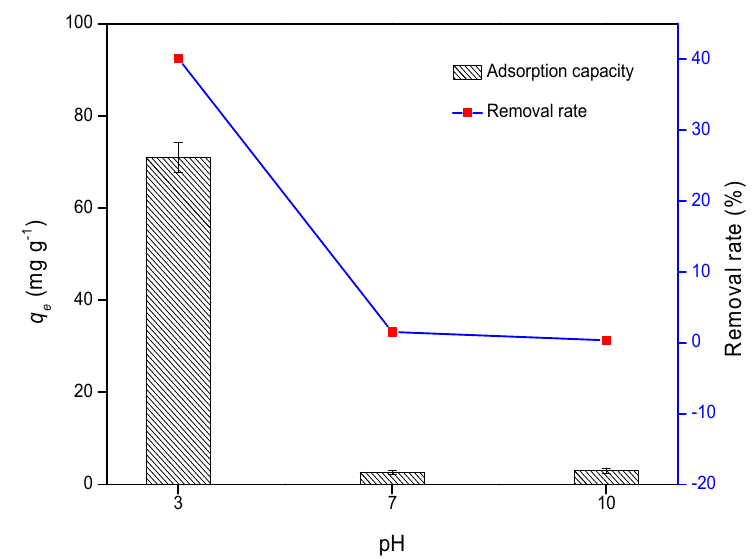
Figure 1. q e and the removal rate of Cr(VI) on wood-based powdered activated carbon (WPAC) at pH 3, 7, and 10.